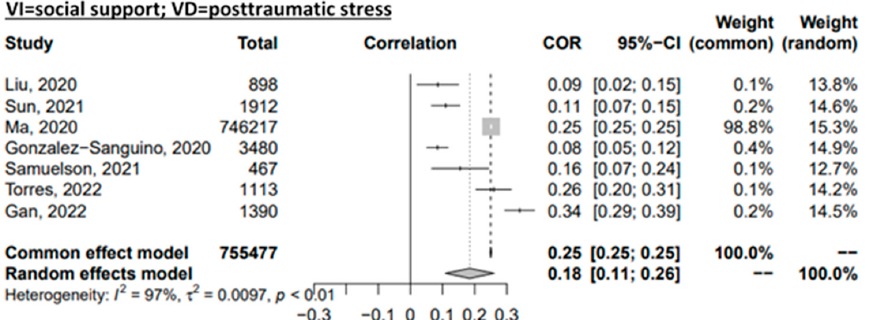
Figure 3. Forest plot of the Omnibus Test for the correlations of social support with mental disorder